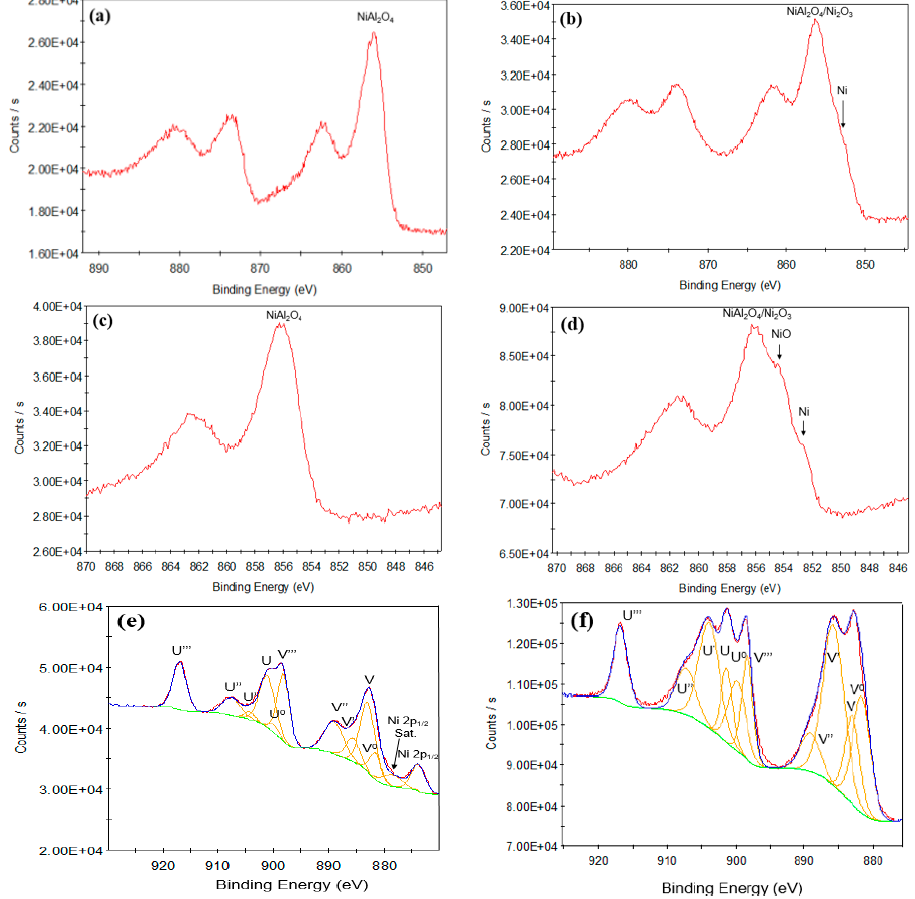
Figure 6. XPS Ni 2p for: ( a ) calcined Ni/Al 2 O 3 , ( b ) reduced Ni/Al 2 O 3 , ( c ) calcined Ni/AlCeO 3 , ( d ) reduced Ni/AlCeO 3 , and Ce 3d peaks for the calcined ( e ) and reduced ( f ) Ni/AlCeO 3 catalyst.